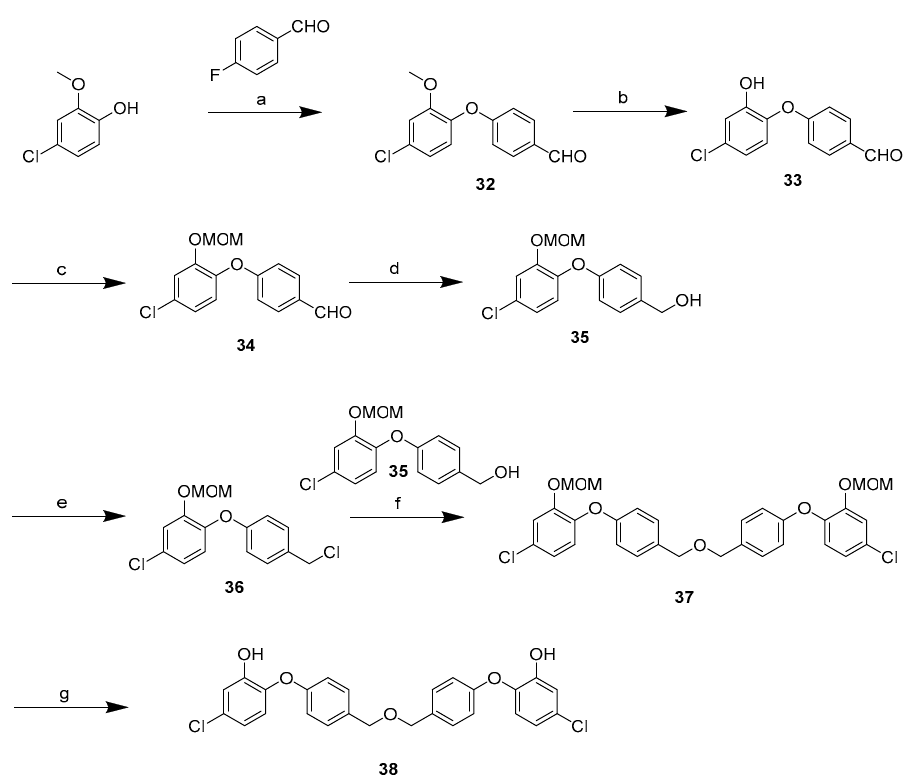
b Scheme 8 . Synthesis of the benzylphenyl compounds via a Baeyer-Villiger oxidation. Reagents and conditions : (a) K 2 CO 3 , DMF, 55 °C to r.t., 4 h, 51%; ( b ) m CPBA, CHCl 3 , r.t., overnight, 68%. 2.4. Inhibition Studies with Purified